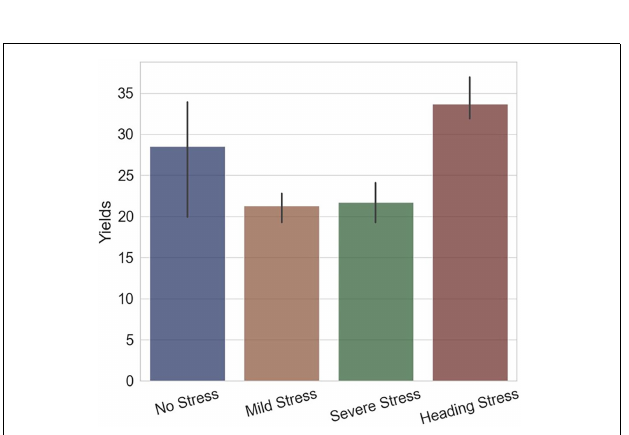
FIGURE 13 | The final yields of experimental groups of different water treatments, the x -axis represents the groups and the y -axis represents the yields (g per